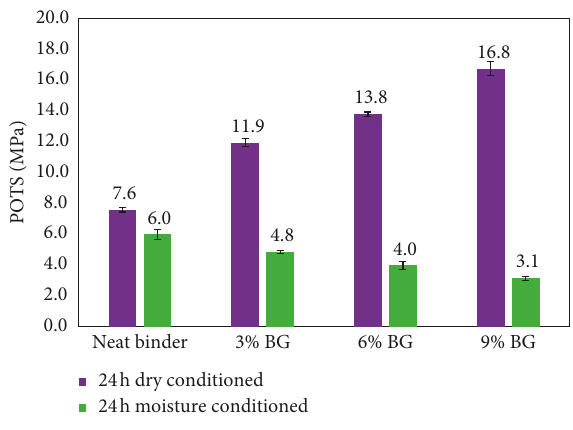
Figure 12: POTS of dry and wet conditioned samples.